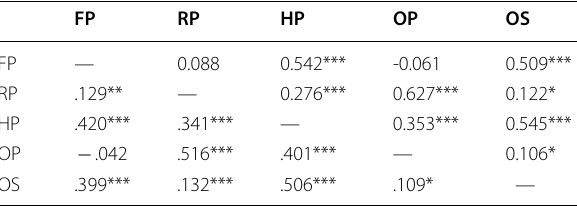
Table 3 Correlations among the dimensions of passion, occupational self-efficacy, and